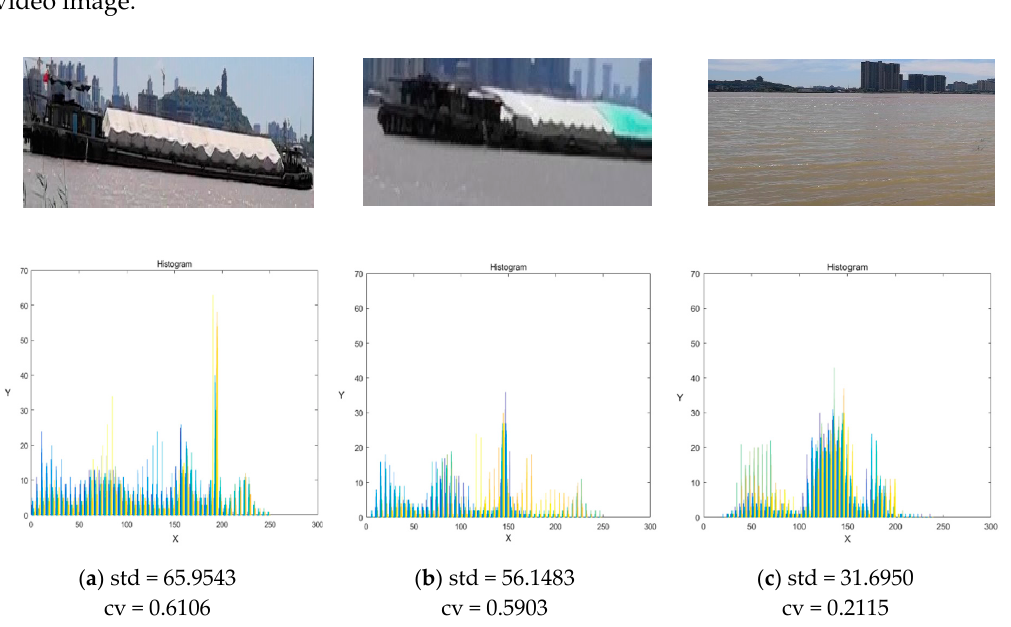
Figure 9. Spatial difference characteristic map of video images.